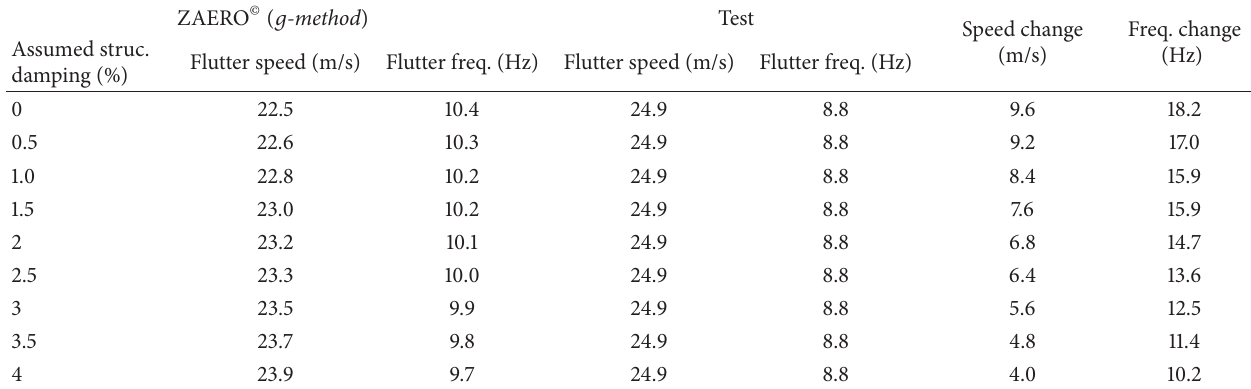
Table 5: Comparison of wind tunnel flutter test with flutter analysis for the rectangular plate for 𝑔 -method . ZAERO © ( 𝑔 -method ) Test (Hz)Assumed struc.